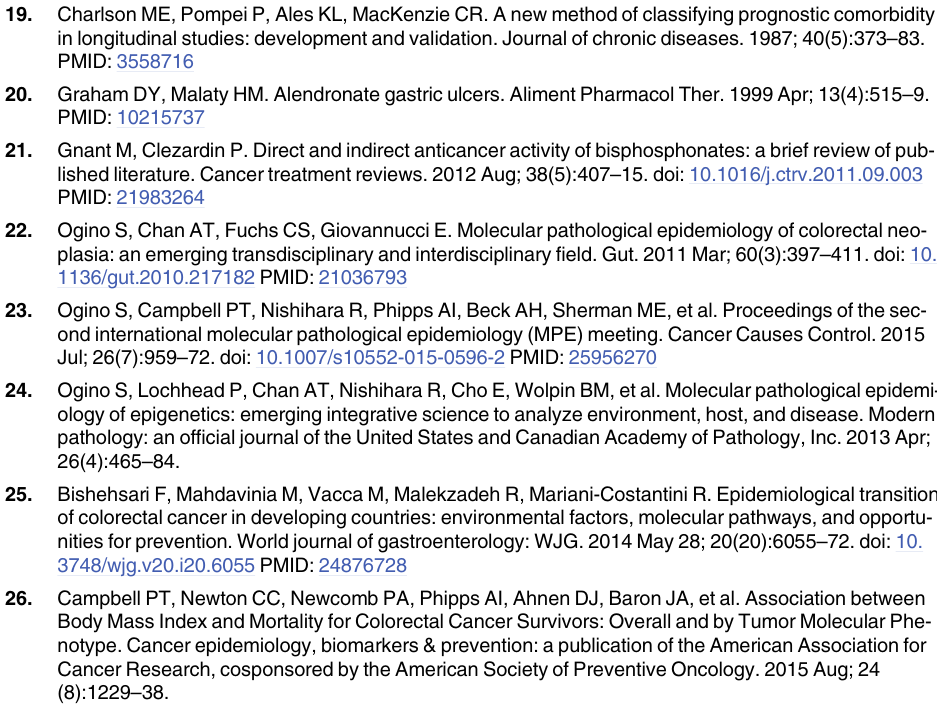
PLOS ONE | DOI:10.1371/journal.pone.0140180 October 7,